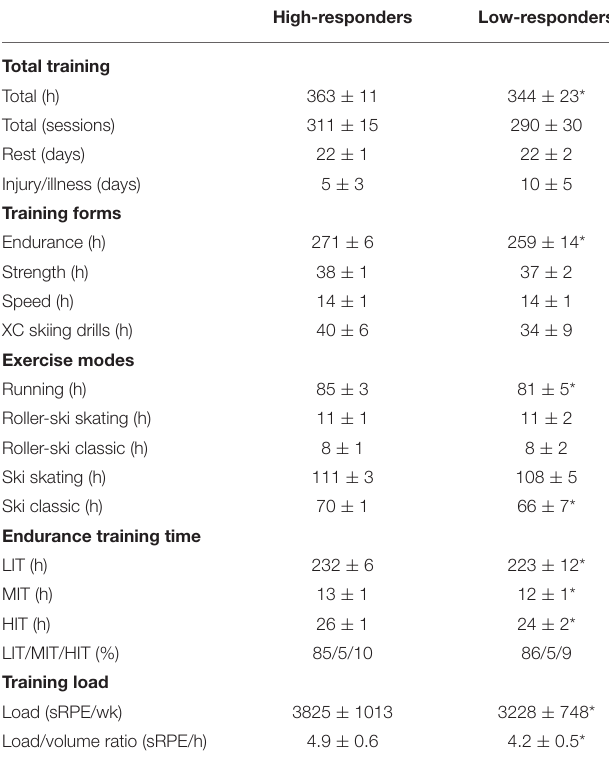
TABLE 2 | Training characteristics (mean ± SD) in high- and low-responders during a 6-month XC ski-specific training period.